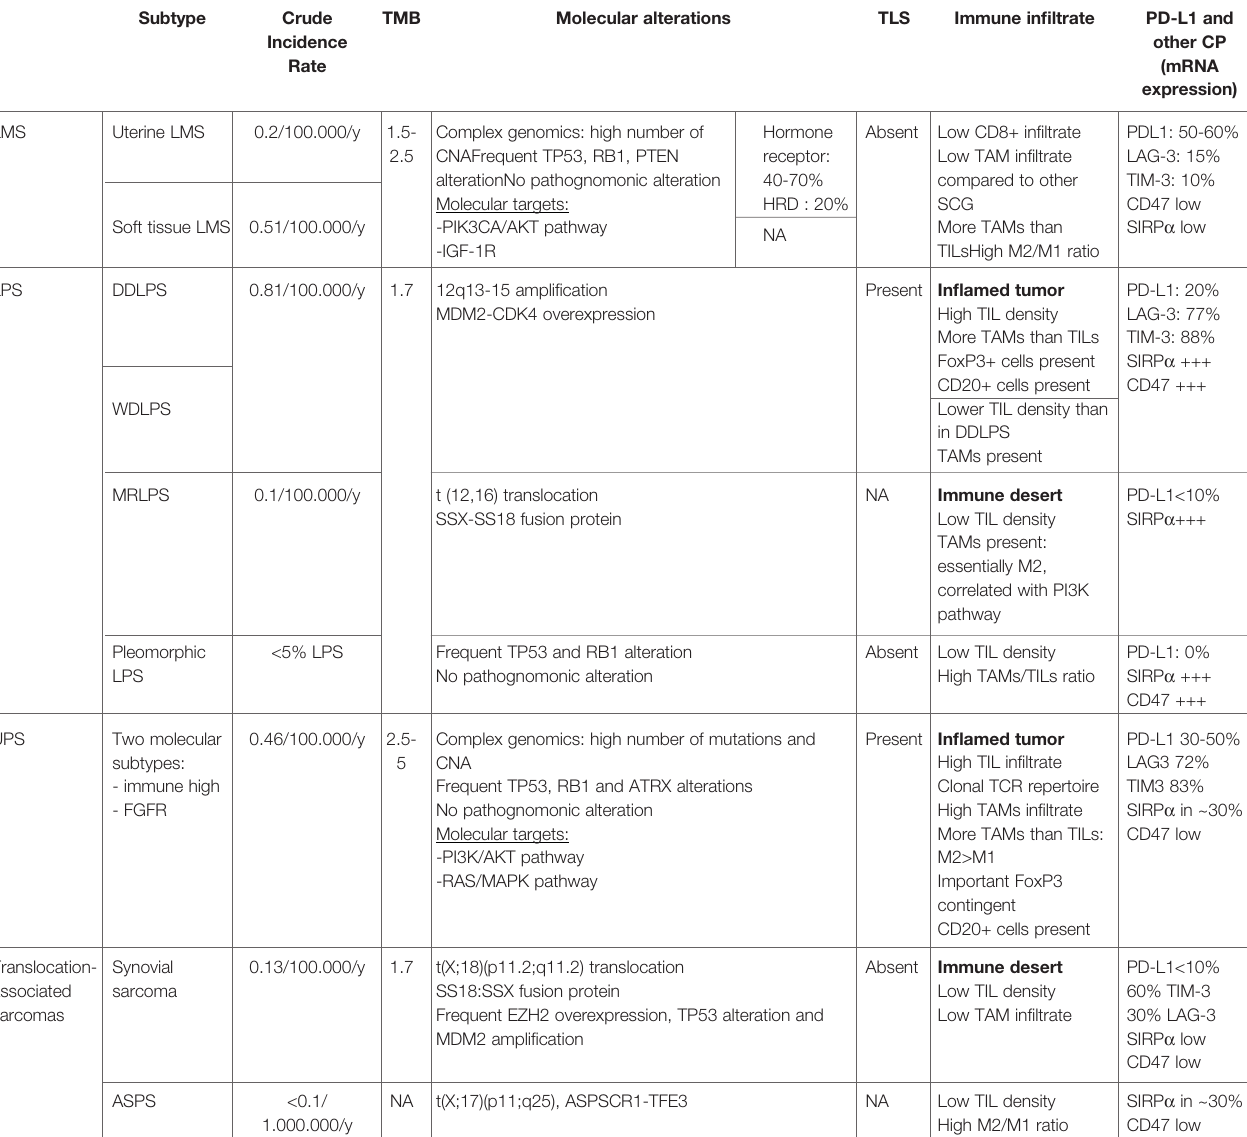
TABLE 2 | Immunological characteristics of the main subtypes of